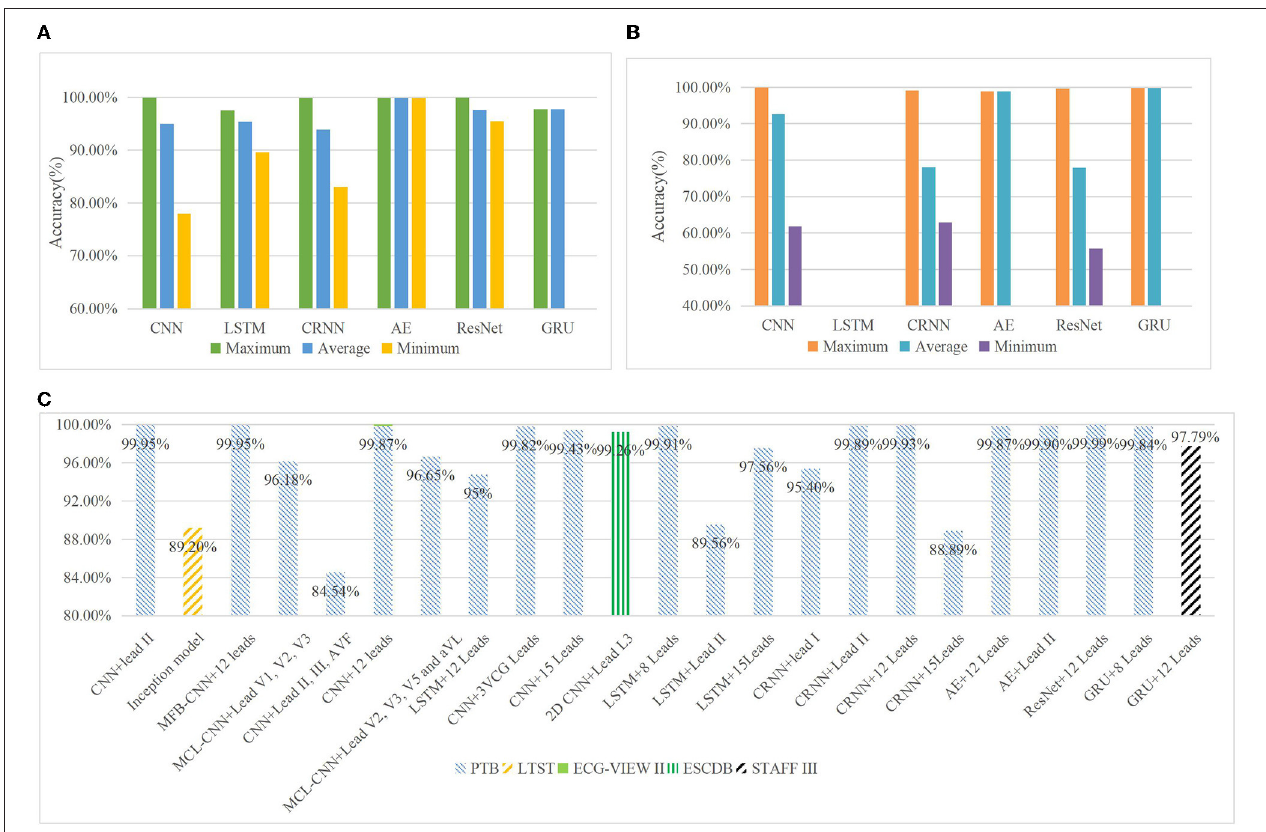
FIGURE 6 | Maximum, average, and minimum accuracies of each DL technique for MI detection (A) . The reported highest accuracy for MI detection is 99.99% in the ResNet model, followed by CNN with an accuracy of 99.95%. The investigated papers with the reported highest accuracy for each model are all beyond 97%, and the average accuracy for each model is all beyond 93%. The reported minimum accuracy for MI detection appears in the CNN model with 78%. Maximum, average, and minimum accuracies of each DL technique for MI localization (B) . The reported highest accuracy for MI localization is 99.87% in the CNN model. There is no research focusing on applying the LSTM model to MI localization, and only one research for AE and GRU model, respectively, applied to MI localization. Therefore, the maximum and average accuracies of autoencoder (AE) and gated recurrent unit (GRU) models are the same, but the minimum is vacant. The minimum accuracies of the remaining three models are all below 65% in MI localization. Maximum accuracies of DL techniques which were trained on investigated ECG datasets and used the different number of leads (C) . Generally, the network that trained on 12 leads ECG data of PTB database has gained higher performance than that on smaller number leads of ECG data. ResNet model with 12 lead ECG data of PTB database achieved the highest accuracy 99.99% in MI localization. The usage of only lead II ECG data has also achieved good results in CNN, CRNN, and AE methods on the PTB database. The main reason is probably the three research with high performance that used only lead II ECG data are just for MI detection, and they cannot obtain matching results in MI